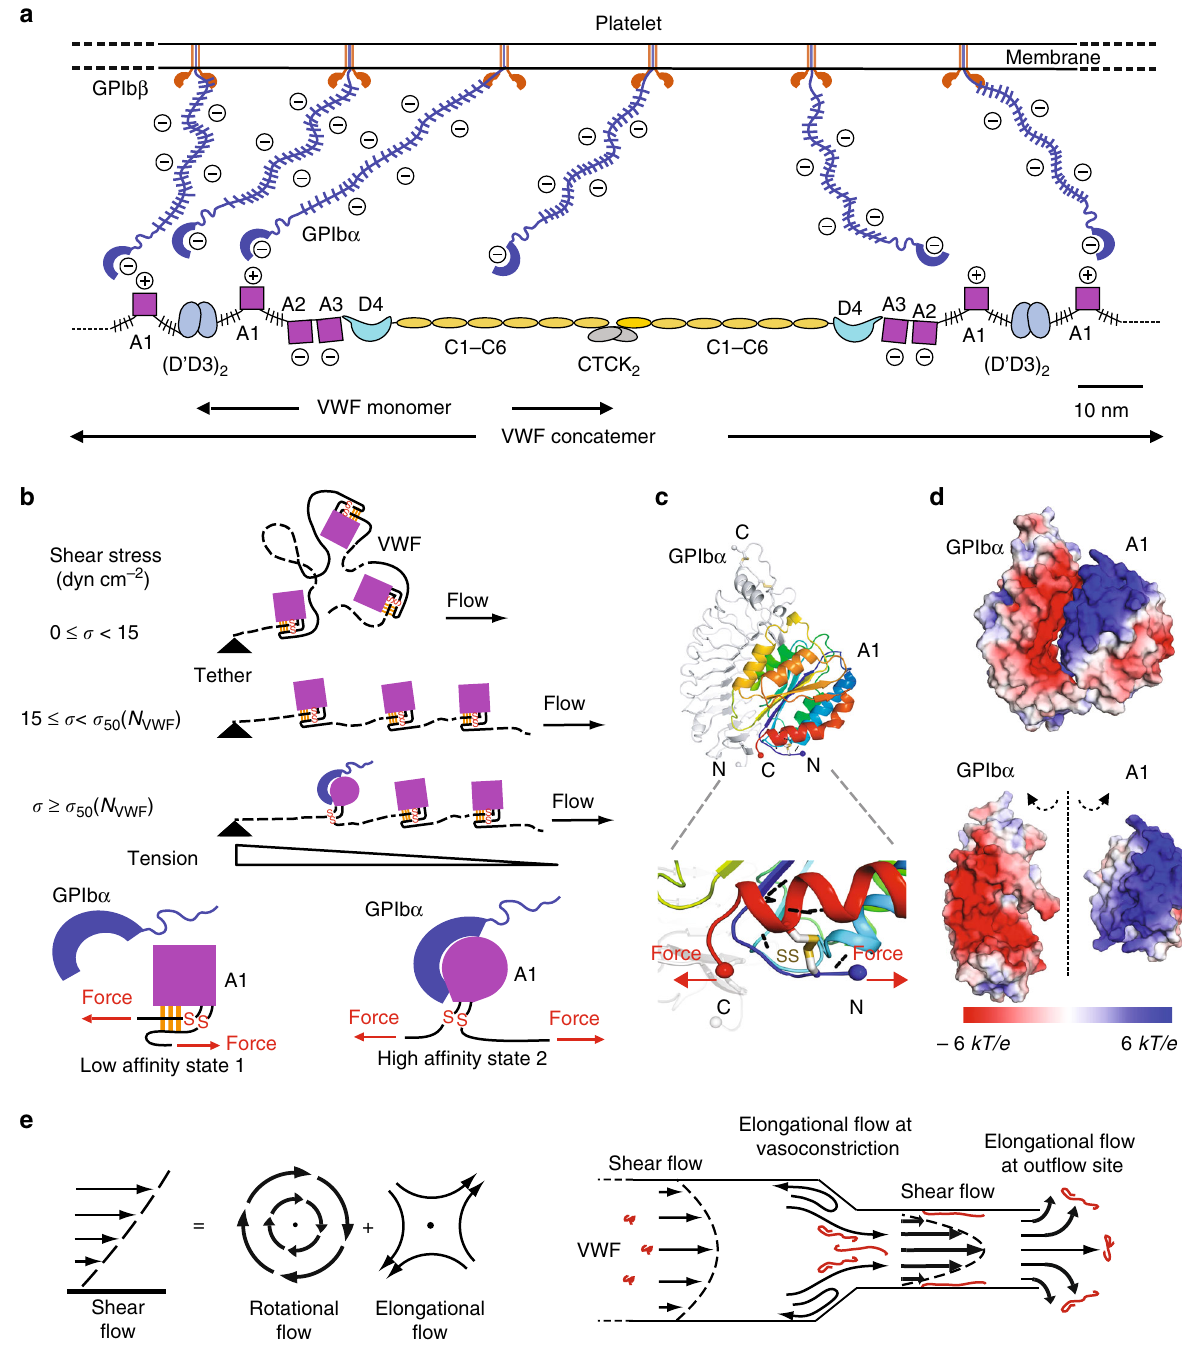
(Table 1). k off was also ~10 times lower in 10 mM NaCl,